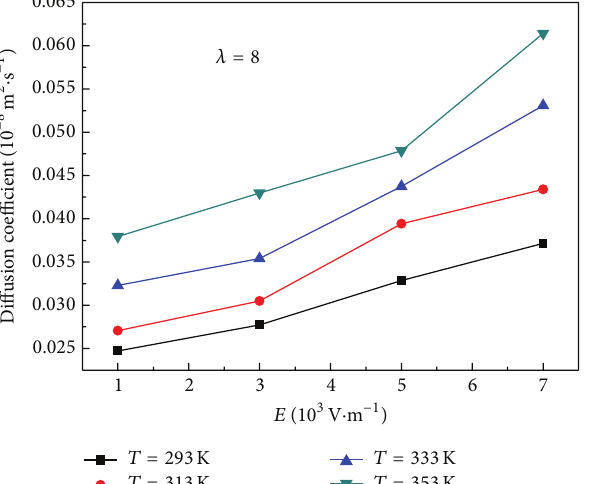
Figure 9: The variations in the diffusion coefficient of the hydrated ion with the electric field intensity at different cell temperatures and 𝜆 = 8